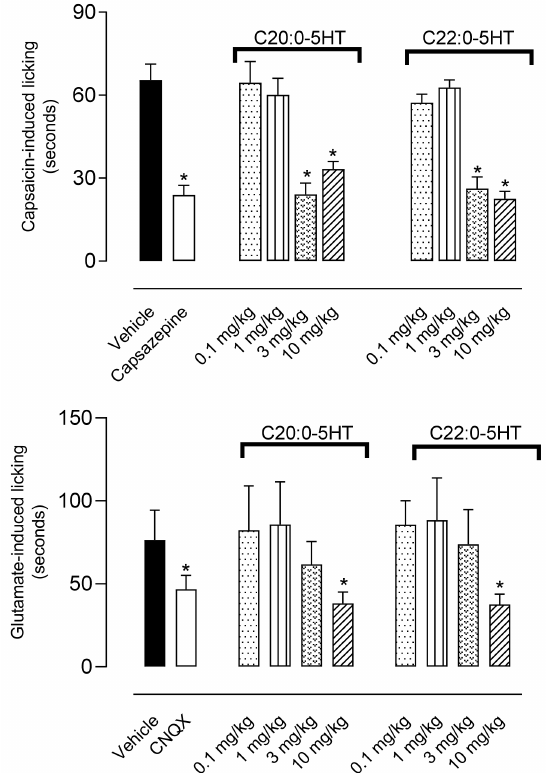
Figure 4. Antinociceptive effect of β N -arachinoyl-5-hydroxytryptamide (C 20:0 -5HT) and β N - behenoyl-5-hydroxytryptamide (C 22:0 -5HT) on the licking response induced by capsaicin or gluta- mate in mice. Animals were pretreated with different doses of C 20:0 -5HT, C 22:0 -5HT, or vehicle 60 min before the injection of capsaicin (1.6 µ g/paw) or glutamate (3.7 ng/paw). Capsazepine (capsaicin receptor antagonist, 3.2 µ g/paw) or CNQX (glutamate receptor antagonist, 30 ng/paw) were injected in mice paws 15 min prior to each respective agonist. The results are presented as mean ± SD ( n = 7 per group) of the time that the animal spent licking the capsaicin- or glutamate-injected paw. One-way ANOVA followed by Tukey’s post hoc test was used to calculate the statistical